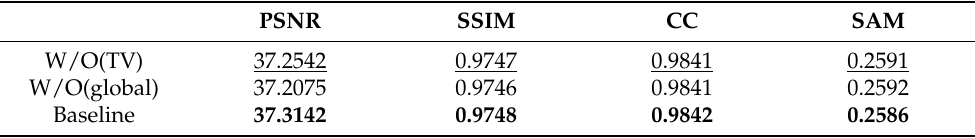
Figure 8. Magnified area from Figure 7. Results of model W/O(global) and W/O(TV) have vivid artifacts while the proposed method has no artifacts in the result. Table 3. Quantitative evaluation of ablation models about loss